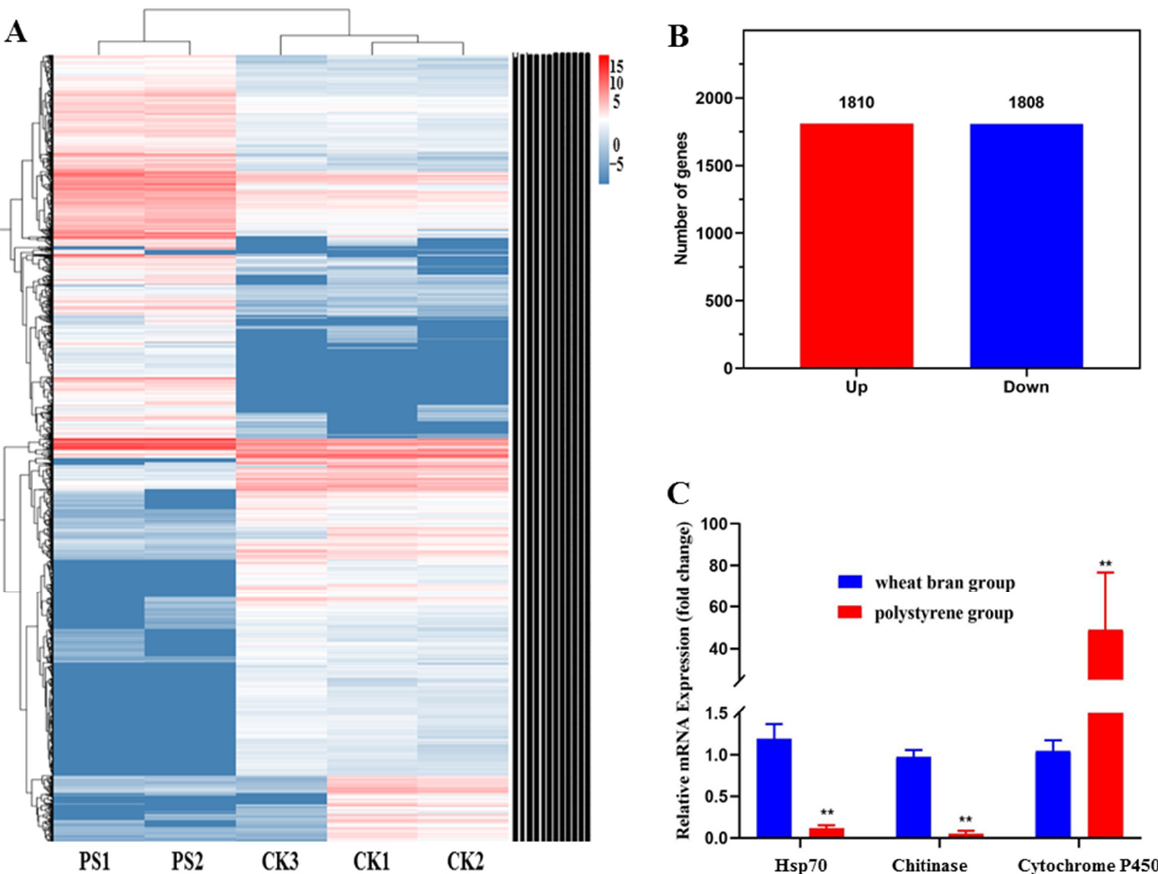
Figure 6. A. Clustering diagram of differential gene expression patterns among groups. B. Differen- tial expression gene statistics between groups. C. qRT-PCR validation of DEGs. One-way analysis of variance (ANOVA) and Dunnett’s test were used to evaluate the differences between groups (** p <